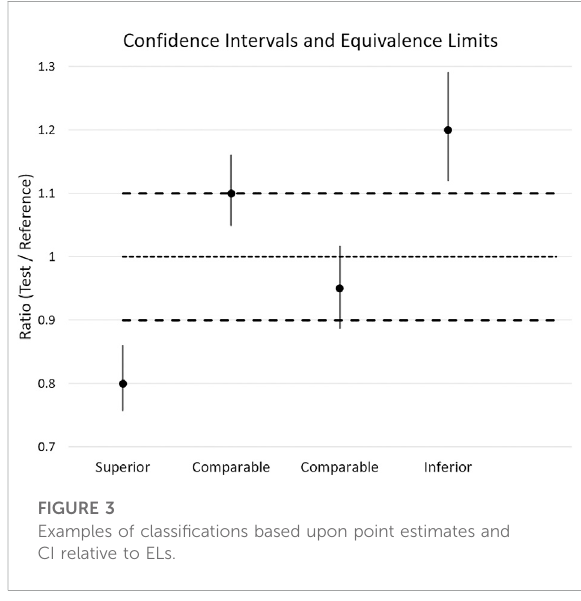
FIGURE 3 Examples of classi fi cations based upon point estimates and CI relative to